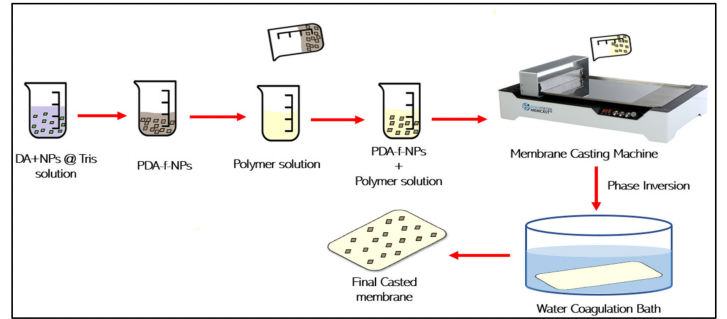
Figure 5. Blending (phase inversion) modification method using